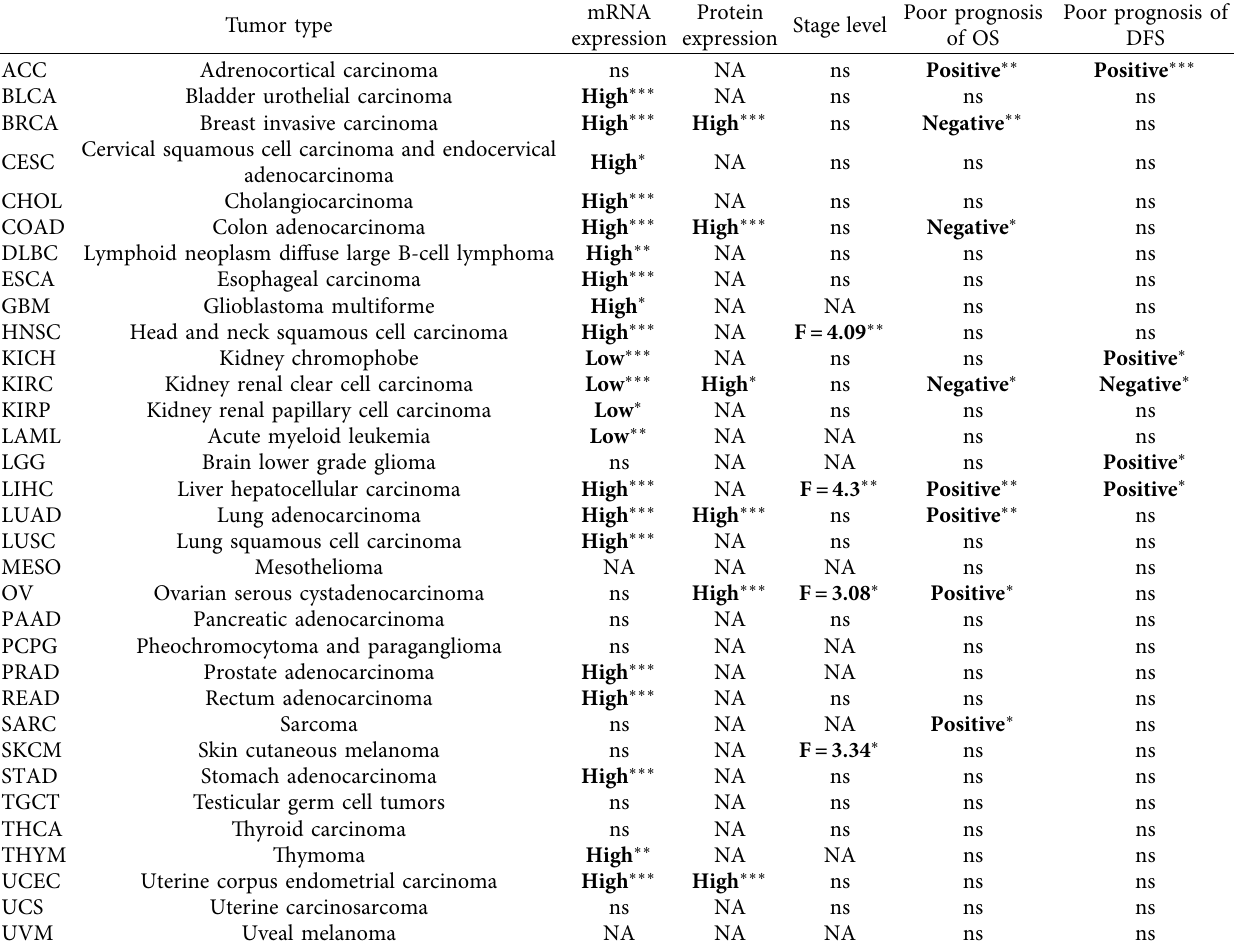
Table 1: The summary of analysis on KDM1A expression and prognosis in different tumors of TCGA Tumor